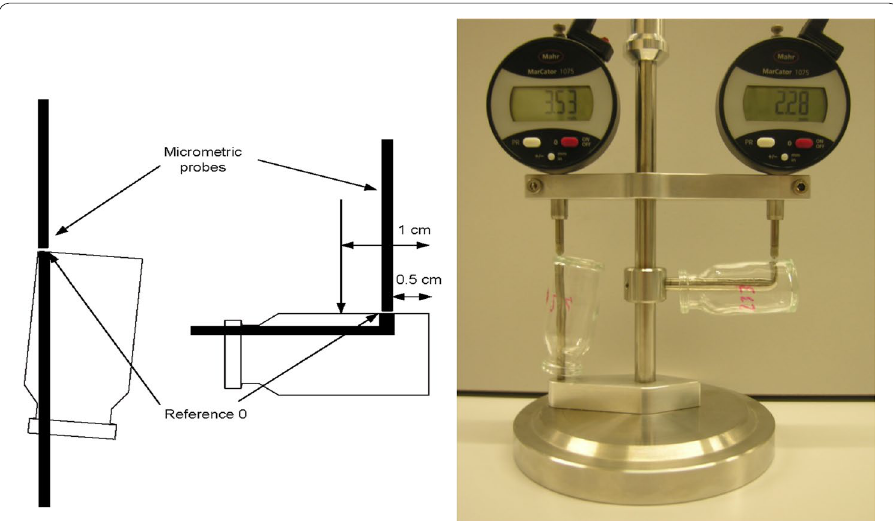
Fig. 4 Left: scheme showing the locations of the probe for measurements at 0.5 and 1 cm with respect to the bottom of the vial and location of the probe for the bottom thickness measurement. For each position the vial is rotated manually to perform 10 measurements along its circumference. Right: picture of the measurement